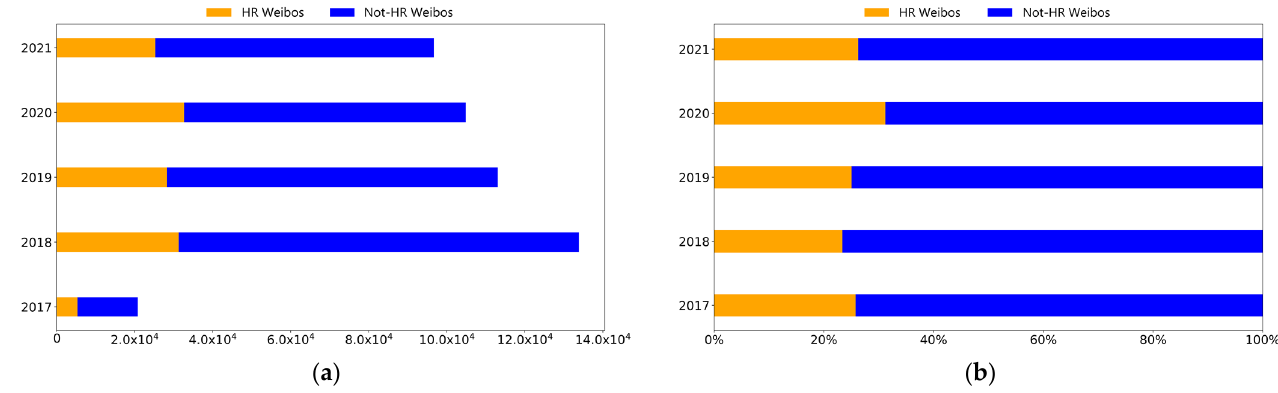
Figure 4. ( a ) Number and ( b ) percentage of HR Weibos among APR Weibos in 2017–2021 (the number of APR Weibos is the sum of HR and not-HR Weibos).